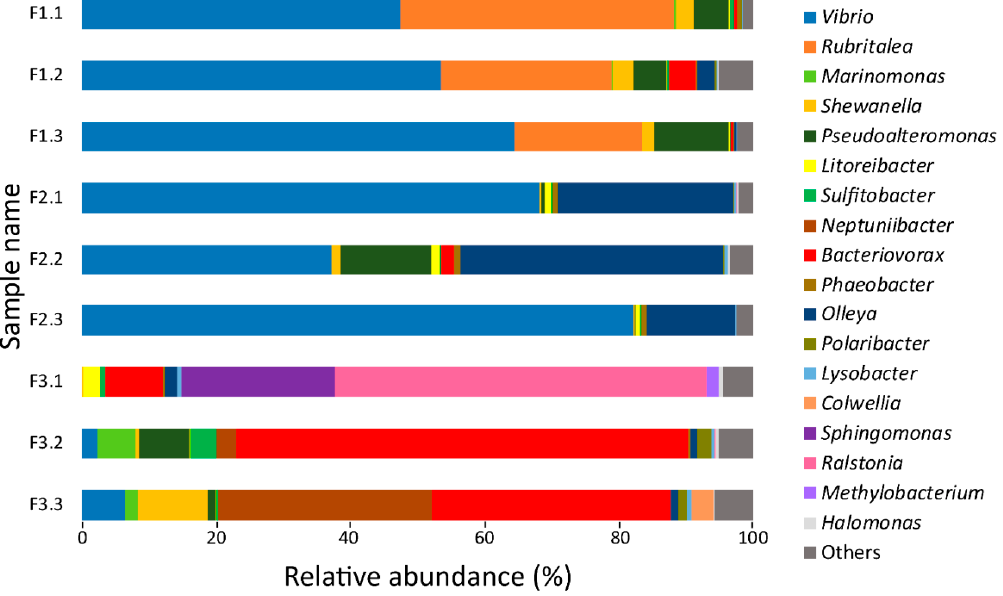
Figure 1. Relative abundances of the bacterial genera identified after 9 days of salmon skin–mucus incubation with sterilized seawater by 16S rRNA gene sequencing analysis. Each technical replicate per sampled fish is visualized separately in this figure. All the OTUs < 0.2% are indicated as “Others”.